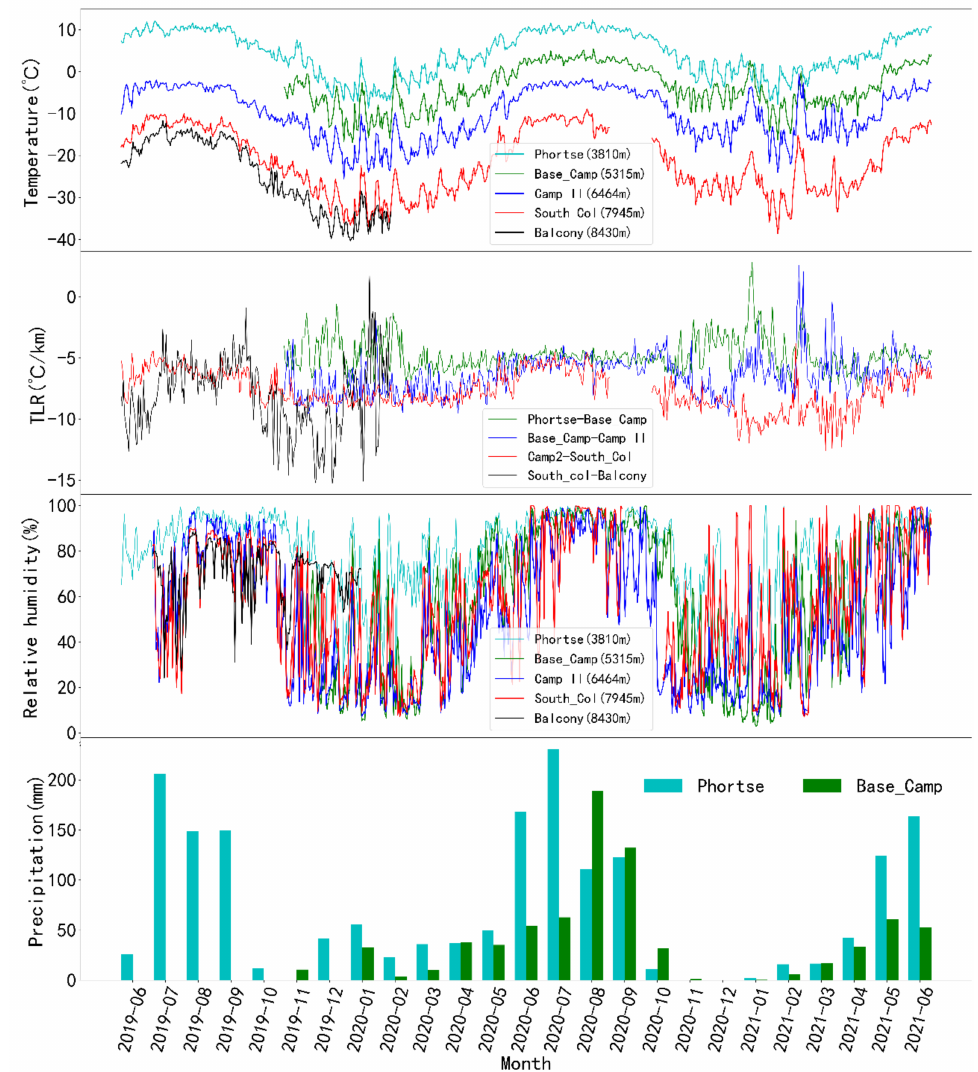
Figure 2. Mean daily temperature, relative humidity, temperature lapse rate (TLR) and monthly precipitation from June 2019 to June